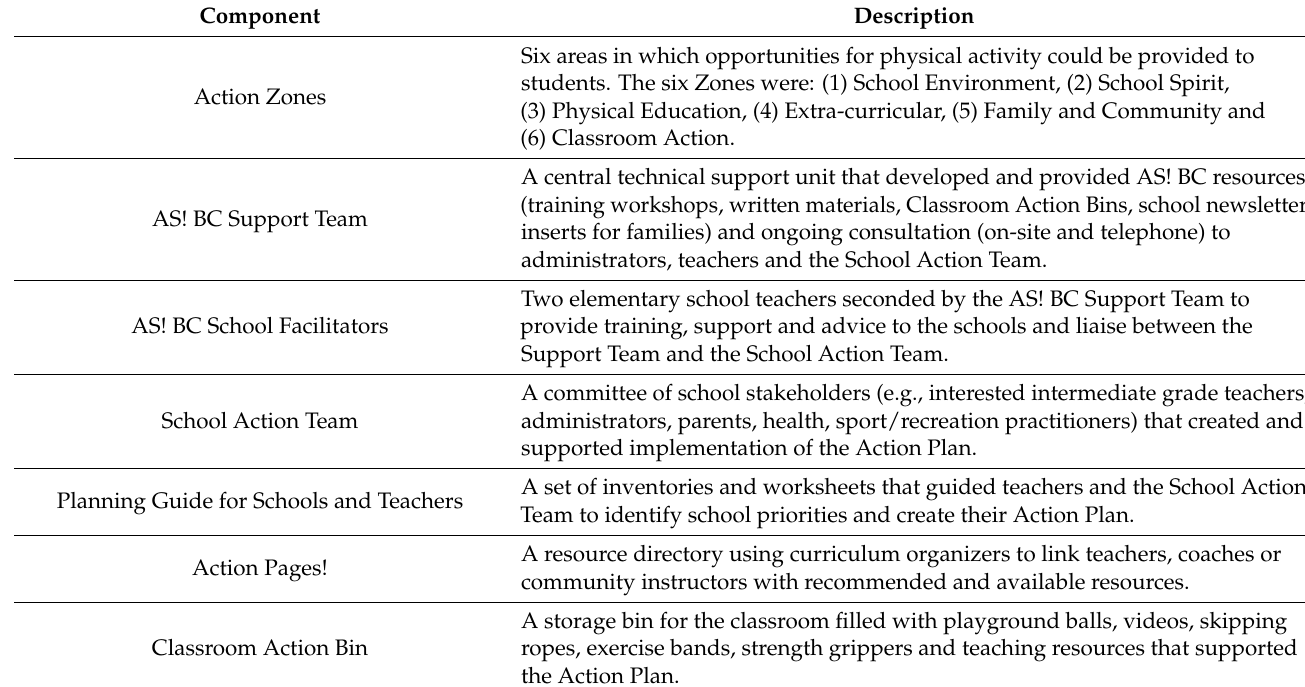
Table 1. Key components of the Action Schools! BC (AS! BC) model. Reprinted from Journal of Science and Medicine in Sport 9(5), Naylor et al [28], Lessons learned from Action Schools! BC—An ‘active school’ model to promote physical activity in elementary schools, p413-423 (2006), with permission from